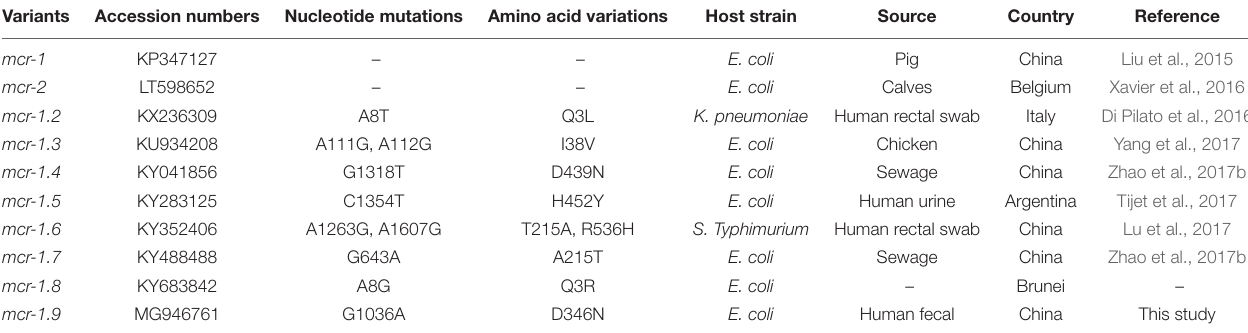
TABLE 1 | List of currently known mcr-1 gene variants and mcr-2 . Variants Accession numbers Nucleotide mutations Amino acid